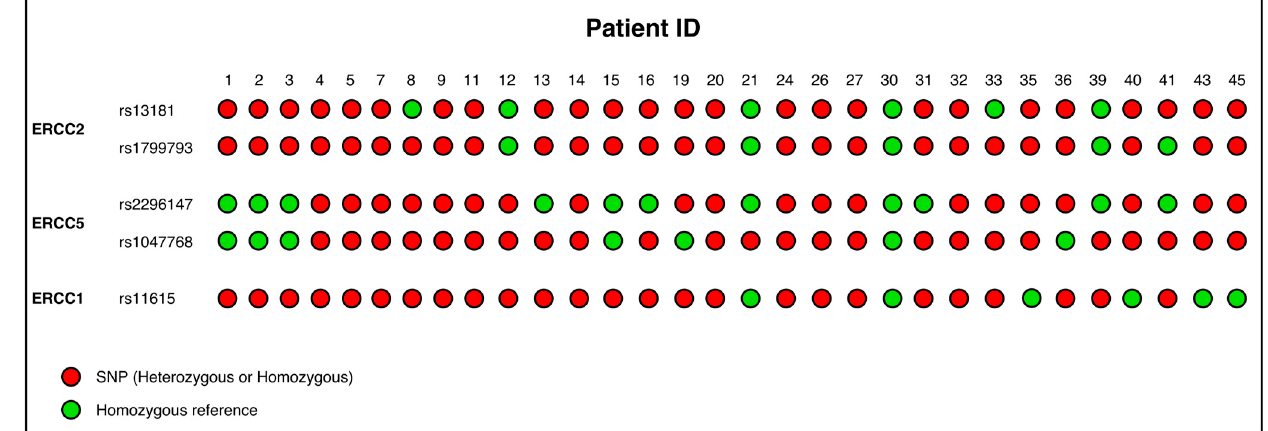
Figure 2. Presence/absence of the ERCC variants in the STS cohort. STS, soft tissue sarcoma.